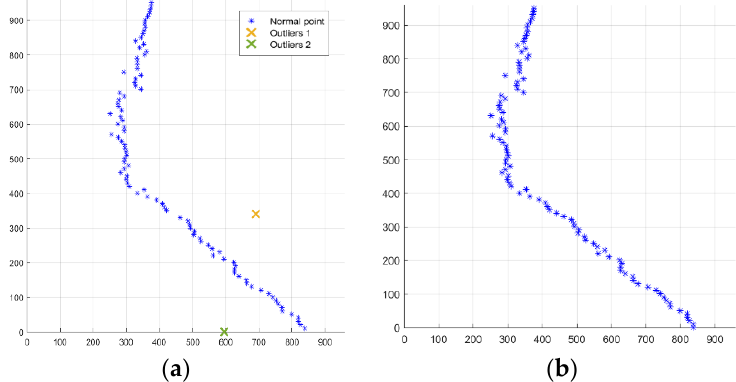
Figure 11. Exception extraction and correction: ( a ) Outliers detection results; ( b ) Exception correction results.